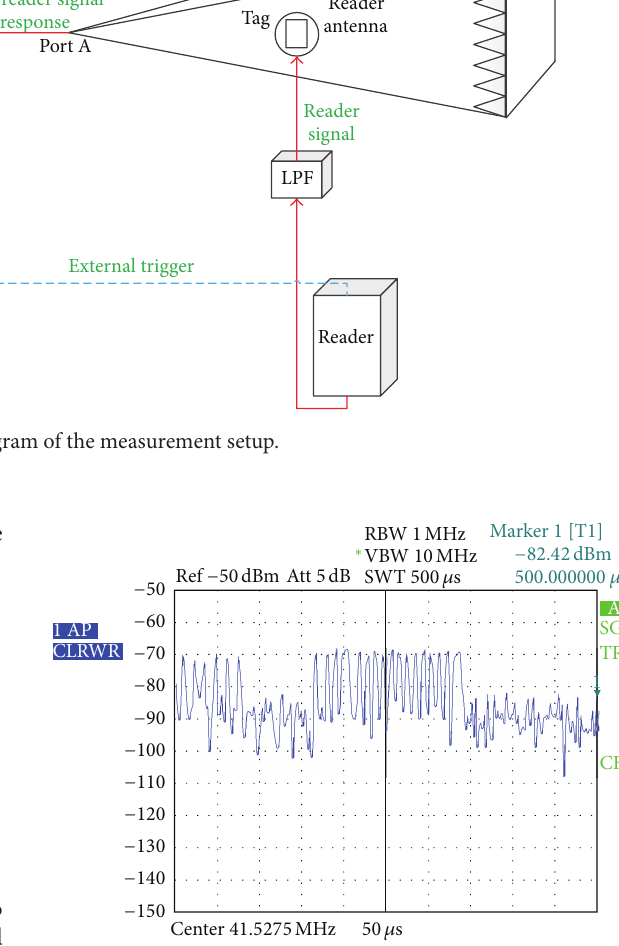
Figure 11: REQA and ATQA on the third harmonic.